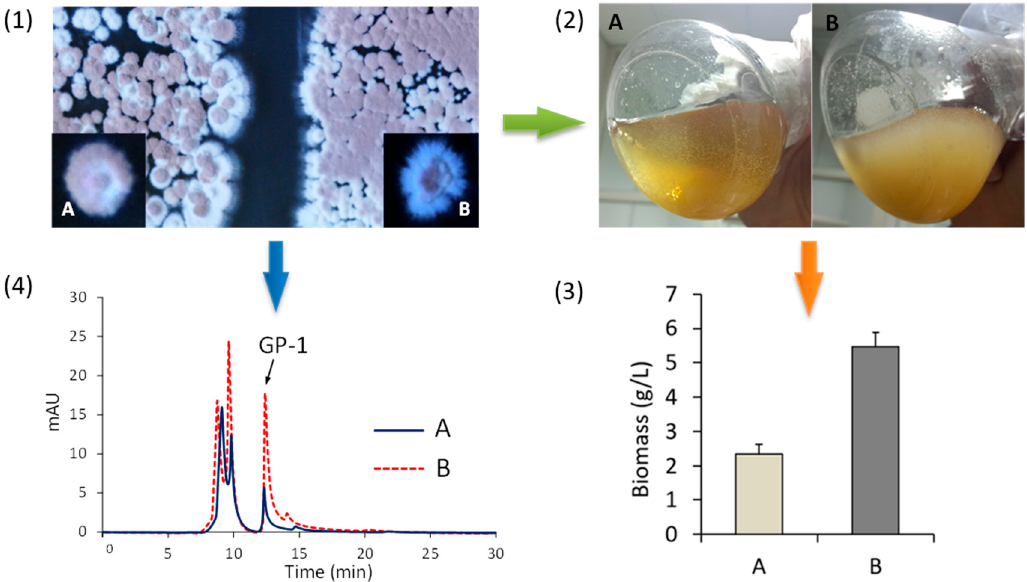
Figure 3. Differences between wild type and mutant of S. kanasensis ZX01 in morphology and production of glycoprotein GP-1. ( A ) wild type strain of S. kanasensis ZX01; ( B ) nsdA disruption mutant in which nsdA was replaced by kanamycin resistance gene ( kan ); ( 1 ) Two strains were cultivated on the Gause-I plate medium for 5 days; ( 2 ) Two strains was cultivated in GCBY liquid medium for 3 days; ( 3 ) The differences of biomass between wild type and ∆ nsdA mutant; ( 4 ) Determination of glycoprotein GP-1 in wild type and ∆ nsdA